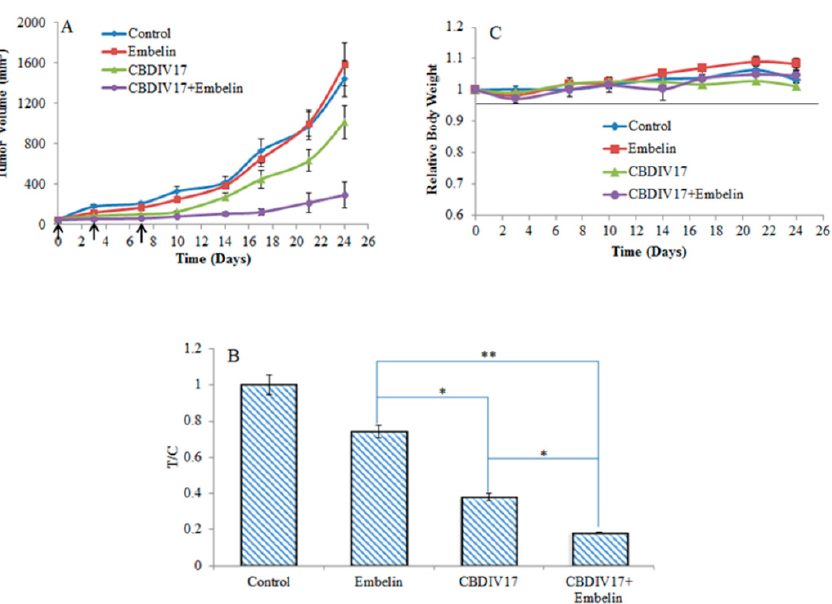
Figure 3. Effect of embelin-loaded PEG-b-p(CB-co-LA) micelles and CBDIV17 on growth of tumors derived from C4-2 prostate cancer cells in nude mice. ( A ) Nude mice bearing 50 mm 3 C4-2 tumors were given an intratumoral injection of 10 mg/kg CBDIV17 and 10 mg/kg embelin, alone or in combination (arrows indicate injection) and tumor size measured. Tumor growth regression was significantly higher for combination therapy group compared to control or monotherapy. Points are mean tumor size ( n = 7); bars, SE. ( B ) Tumor suppression (T/C) was computed as the ratio of mean tumor volume in treated groups compared with control when last injection was